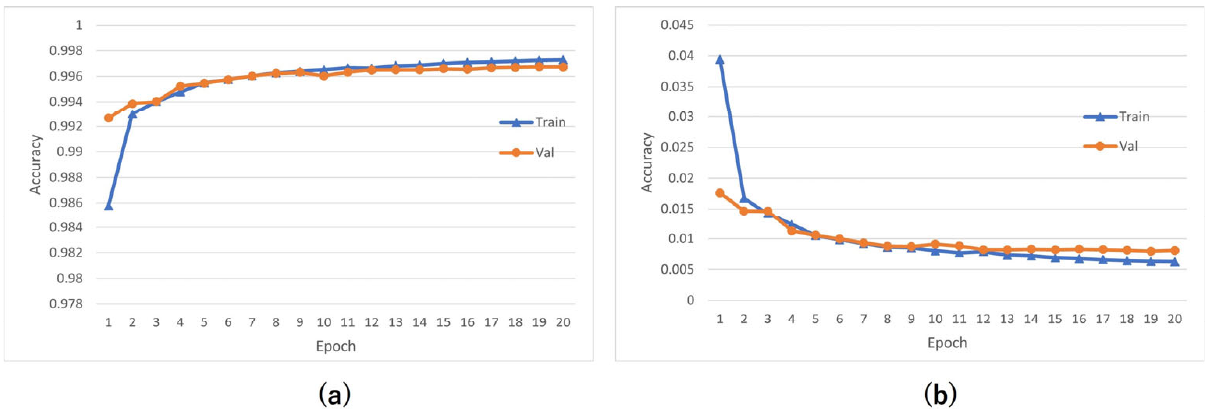
Figure 1. Example of the accuracy and the loss of each epoch during model training. ( a ) accuracy, ( b ) loss.